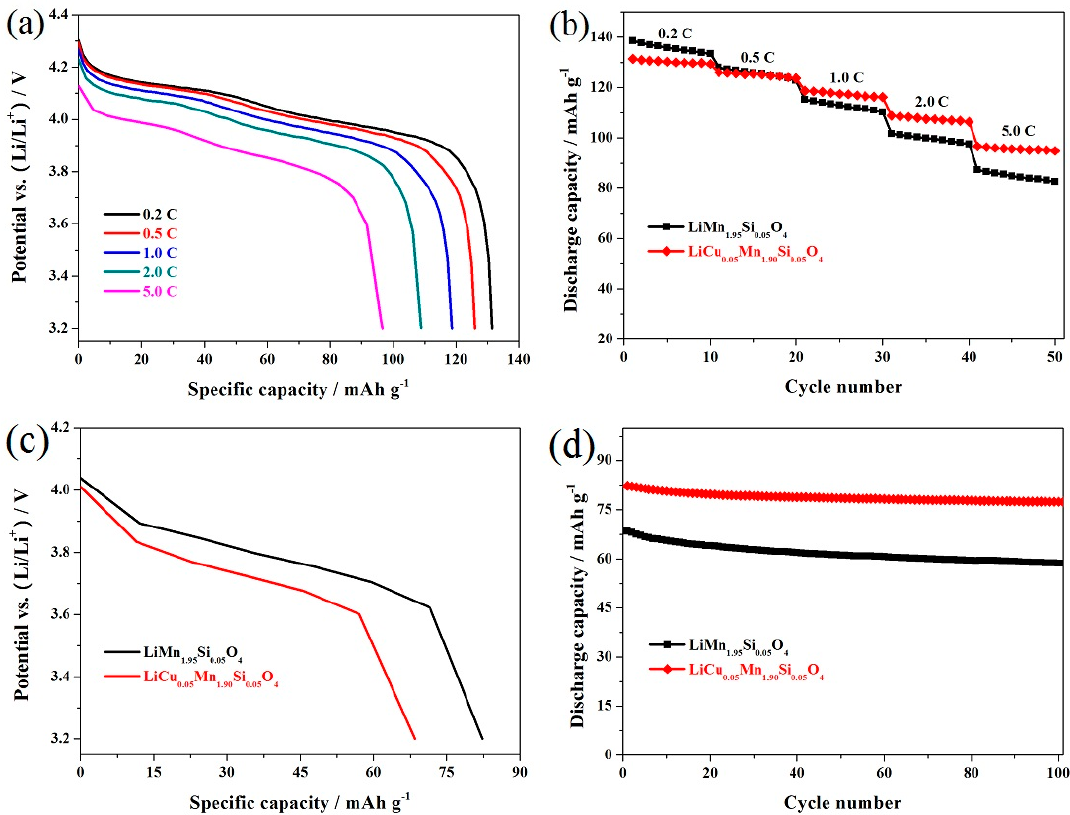
Figure 4. ( a ) Discharge curves of the representative LiCu 0.05 Mn 1.90 Si 0.05 O 4 sample at varying rates; ( b ) Cycling performance of the LiCu x Mn 1.95 − x Si 0.05 O 4 (x = 0, 0.05) samples at varying rates; ( c ) Initial discharge curves and ( d ) Cycling performance of the LiCu x Mn 1.95 − x Si 0.05 O 4 (x = 0, 0.05) samples at 10 C.